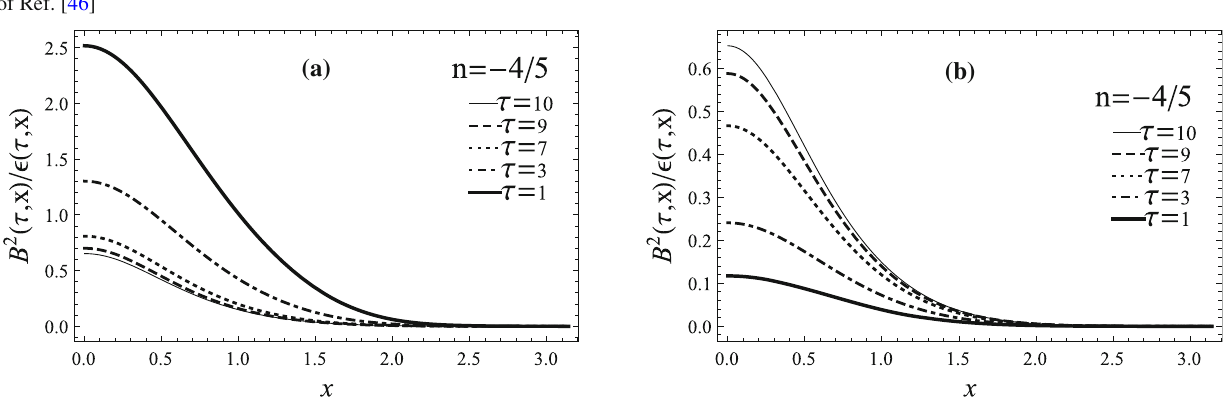
Fig. 14 B 2 (τ, x )/(cid:3)(τ, x ) versus x plotted at different times for n = − 4 / 5, a numerical solutions (present work), b analytical